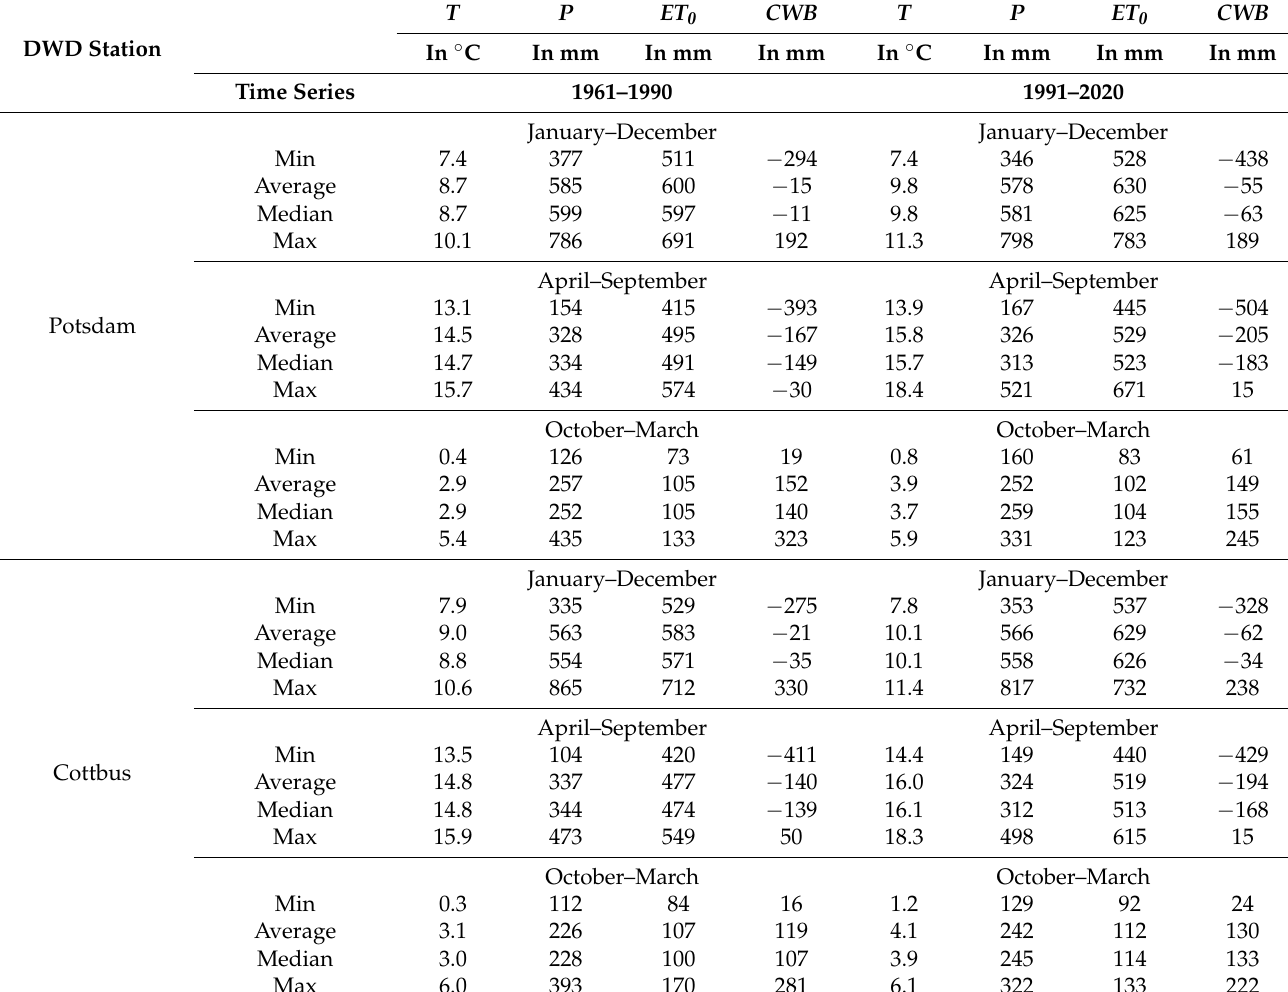
Table 1. Annual and half-yearly average of the air temperature ( T ), sums of precipitation ( P ), FAO grass reference evapotranspiration ( ET 0 ), and climatic water balance ( CWB ) for the 1961/1990 and 1991/2020 time series at DWD stations in Potsdam and